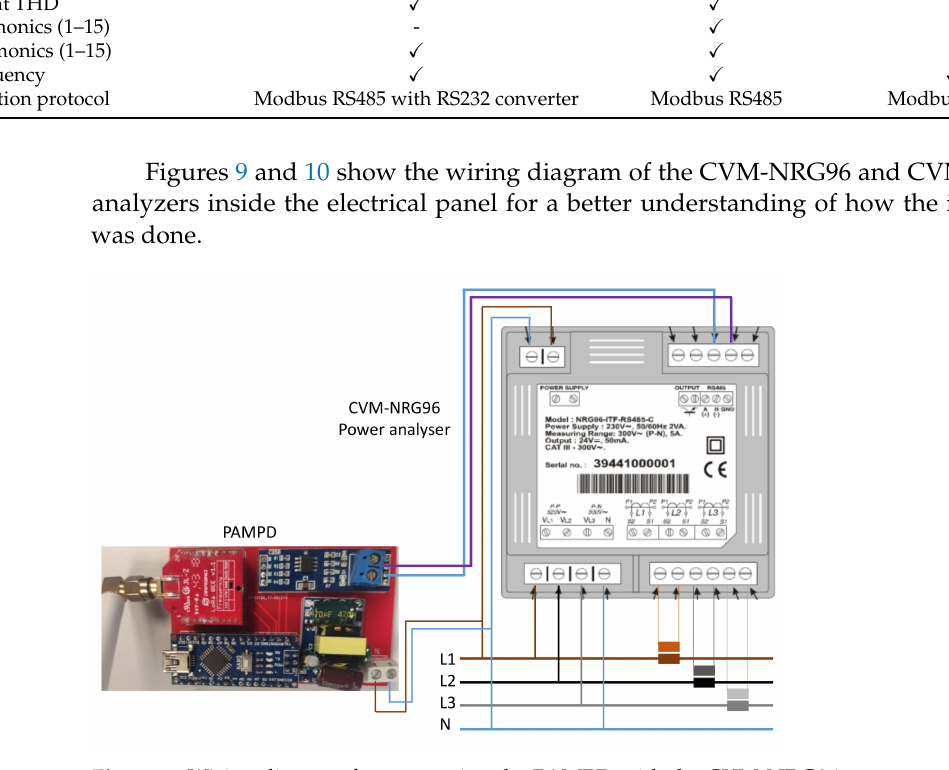
Figure 9. Wiring diagram for connecting the PAMPD with the CVM-NRG96 power analyzer into an electrical panel.